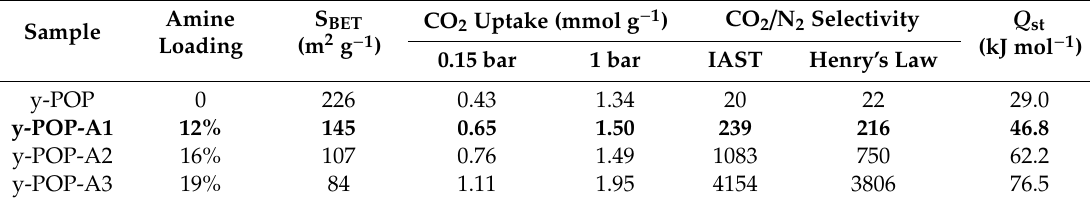
Table 1. A summary of specific surface area (S BET ), CO 2 adsorption capacity (273 K), CO 2 -over-N 2 selectivity (273 K), and Q st of CO 2 adsorption at the low coverage of CO 2 for ynone-linked porous